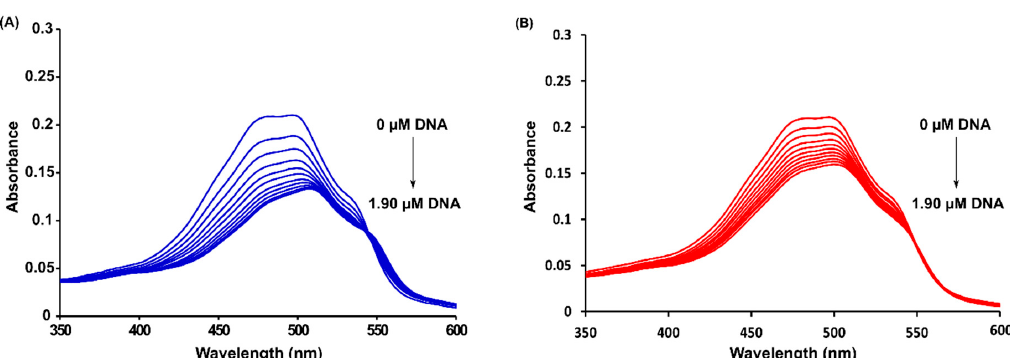
Figure 4. UV-Vis absorption spectra of DOX ( A ) and 4-pep–DOX ( B ) in the presence of dsDNA at various concentrations in 10 mM Tris-HCl buffer (pH 7.2) at 25 °C (the initial concentration of DOX and 4-pep–DOX = 18 µM).